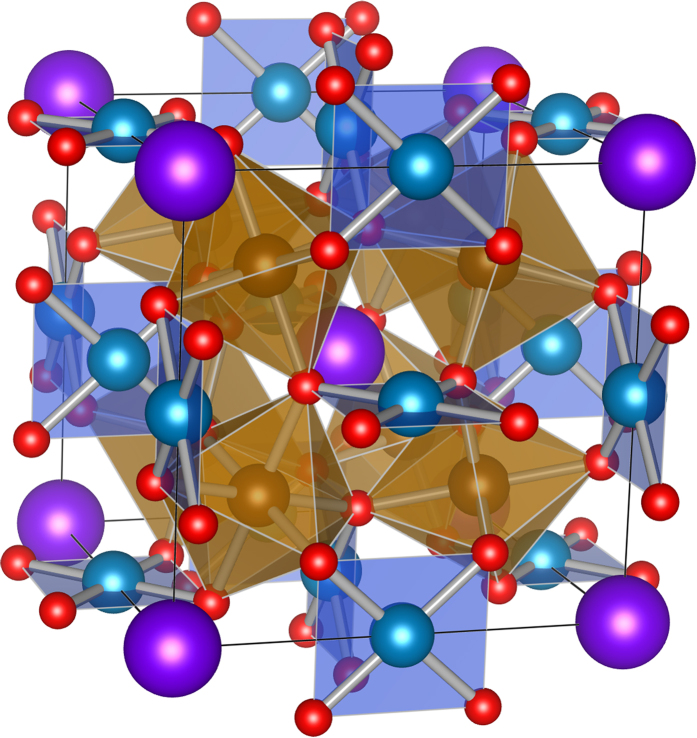
Conventional cell of EuCu3Fe4O12.Eu atoms are purple, Cu are blue, Fe are brown and O atoms are red colored.